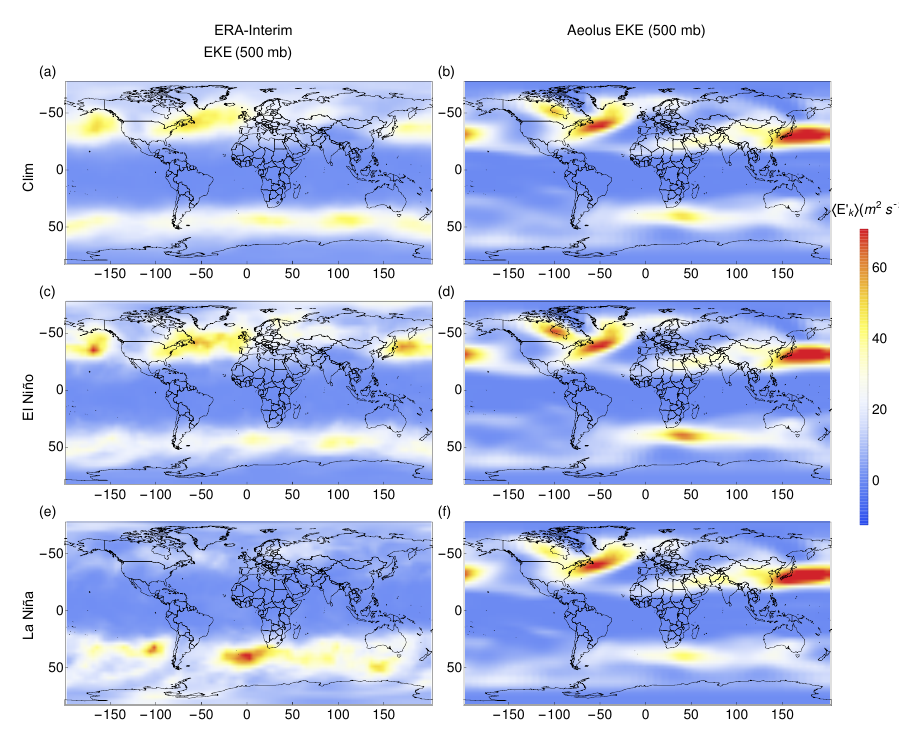
(cid:105) in February at 500mb (compare Fig. 1). k